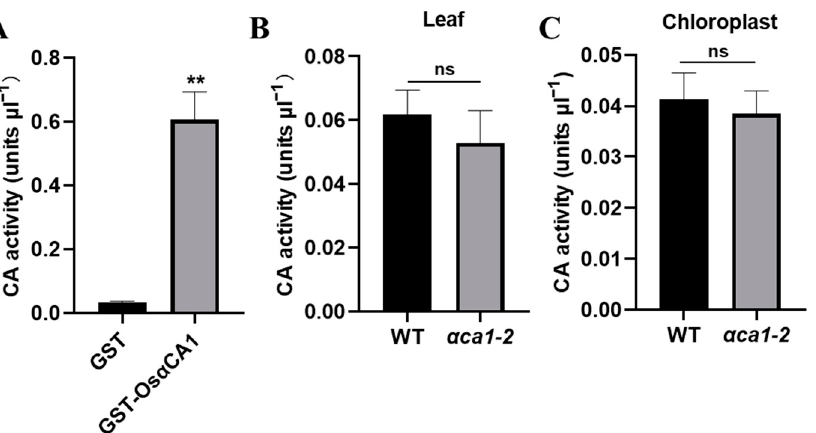
Figure 6. Os α CA1 deficiency reduced the CA activity in rice chloroplasts. ( A ) Measurements of the CA activity of Os α CA1. Os α CA1 fused with GST was purified from Escherichia coli . GST was used as the control. ( B ) The CA activity in leaves of WT and α ca1-2 . The total proteins of flag leaves were extracted to detect CA activity. ( C ) The CA activity in chloroplasts of WT and α ca1-2 . The chloroplast proteins of flag leaves were extracted to detect CA activity. All values are shown as means ± SEM determined via Student’s t -test, where ** p < 0.01, ns indicates no significant difference, and n ≥ 8.